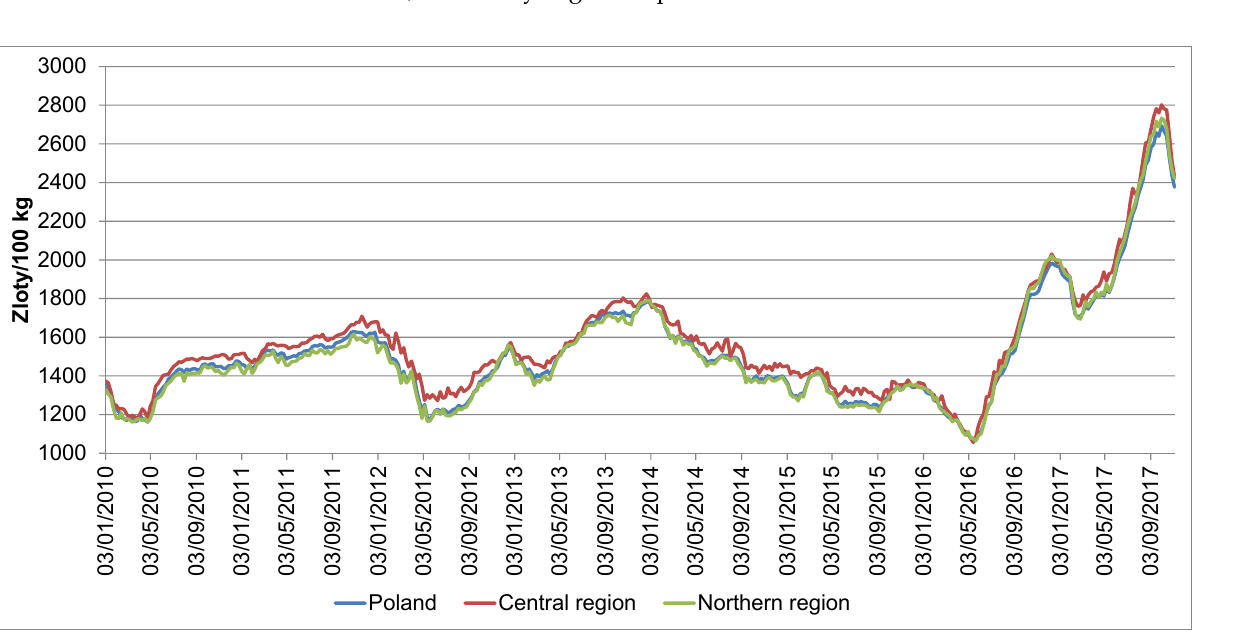
Figure 2. Weekly prices of butter in 100 kg blocks in the country and two regions, 3 January 2010 to 5 November 2017, in 2PLN.